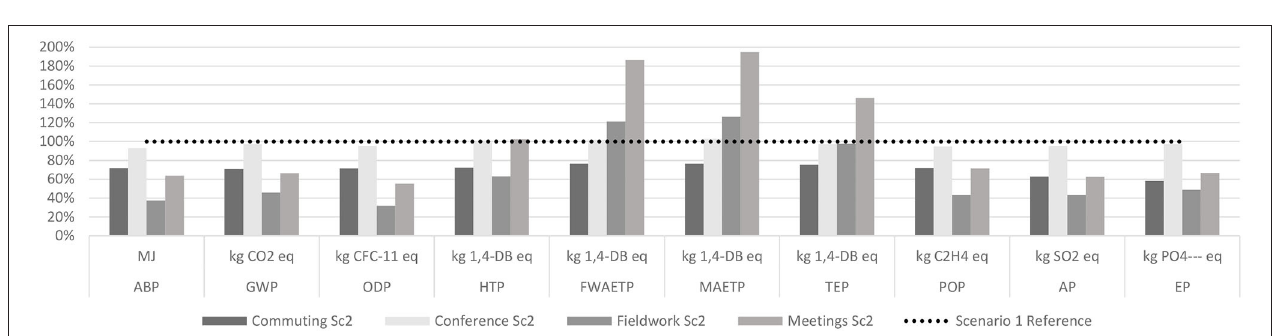
FIGURE 4 | A comparison of the reference scenario with and without the commuting category included.